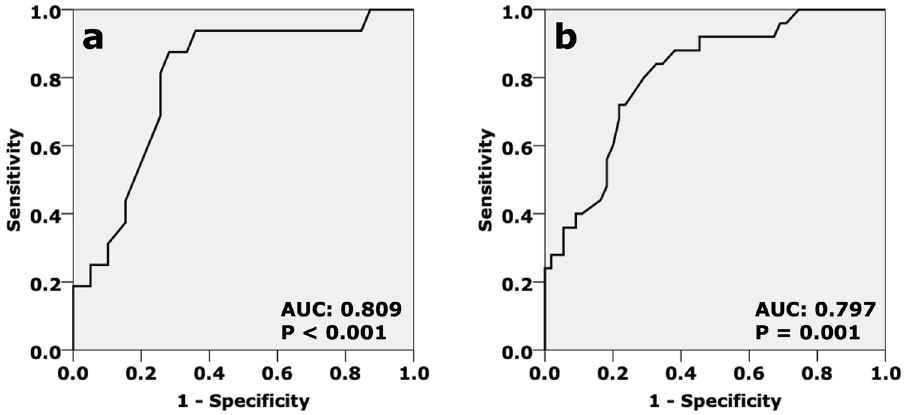
Figure 3. Receiver operating characteristic curve to predict the ghost meniscus sign on a fat-suppressed T2-weighted sagittal image. ( a ) Non-ROA group; ( b ) ROA group; AUC: area under curve; ROA: radiographic knee osteoarthritis (Kellgren-Lawrence grade ≥ 2).